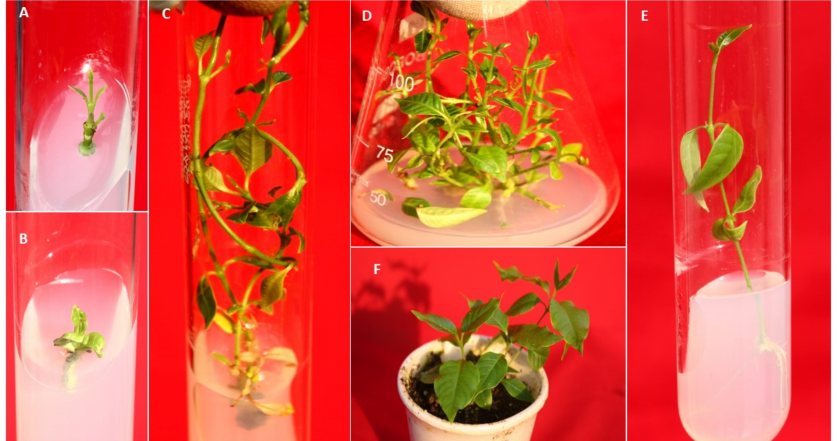
Figure 4. A micropropagation protocol for D. arayalpathra . ( A , B ) Different explants, viz., nodal seg- ment and shoot tip explant inoculated on MS + 5.0 µ M BA after 6 weeks of culture. ( C ) Proliferating NS-raised culture on MS + 5.0 µ M BA after 6 weeks of culture. ( D ) NS-raised culture showing elonga- tion on MS + 5.0 µ M BA + 0.5 µ M NAA + 20 µ M ADS after 3 weeks of inoculation. ( E ) Development of fibrous roots on Half-strength MS + 5.0 IAA after 4 weeks of culture. ( F ) Successfully acclimatized in vitro rooted plantlets of sterile soilrite after 6 weeks of transfer.